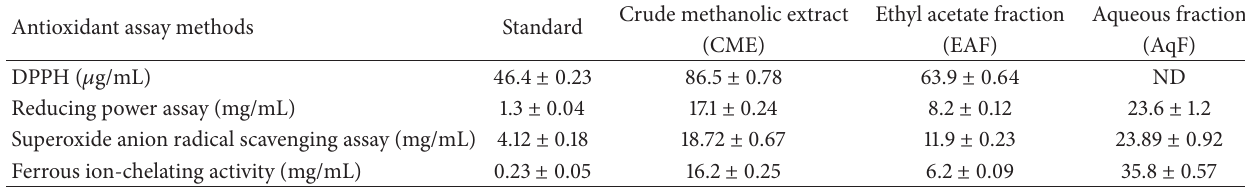
Table 3: EC 50 values in different in vitro antioxidant assay